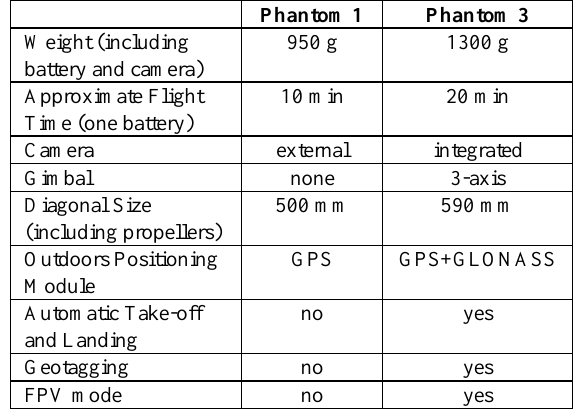
Table 1. Main characteristics of the RPAS used during the test.